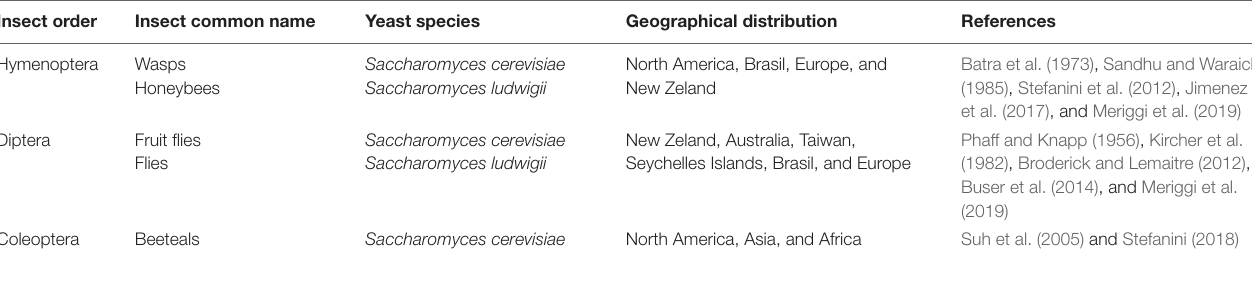
TABLE 1 | Isolation of Saccharomyces spp. in the insects’ gut and geographical distribution. Insect